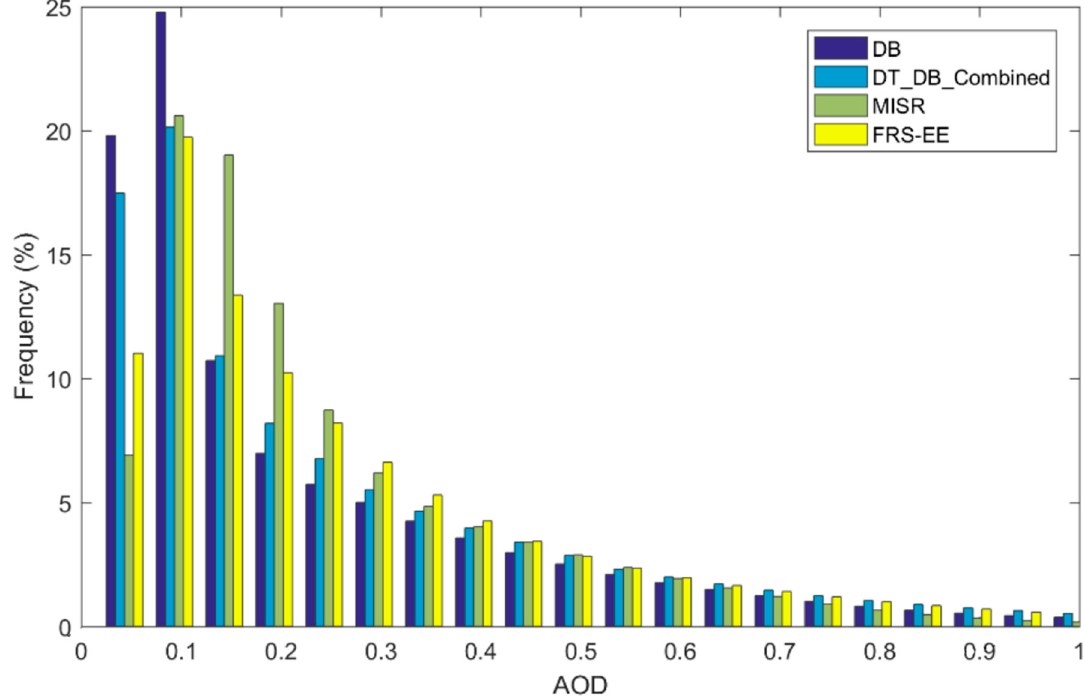
Figure 10. Frequency distribution for DB AOD, DT_DB_Combined AOD, MISR AOD, and FRS-EE fused AOD.